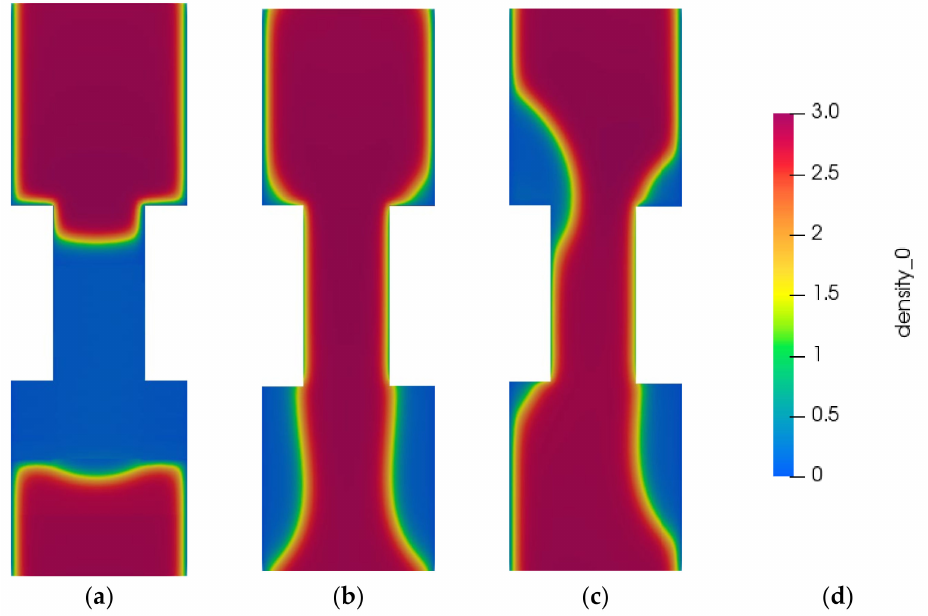
Figure 6. CO 2 penetration into the channel initially filled with water at 297,500 ts and contact angle 70 ◦ . ( a ) G f = 3.5 × 10 − 5 . ( b ) G f = 4 × 10 − 5 . ( c ) G f = 6 × 10 − 5 .